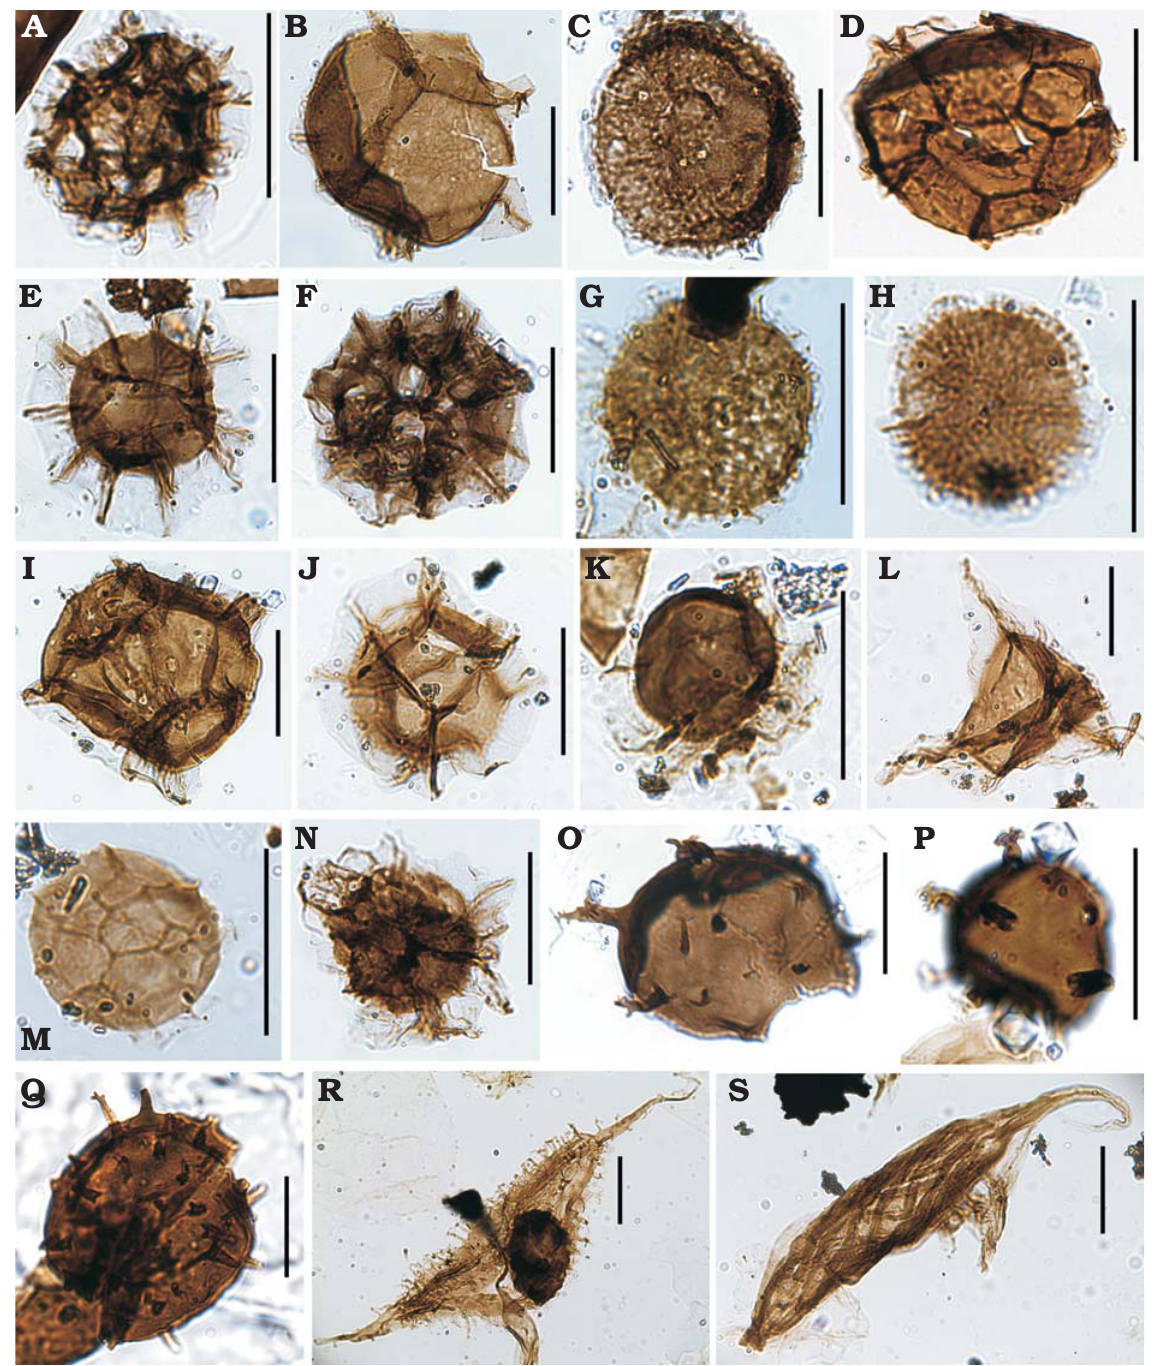
Fig. 6. Palynomorphs from the studied sections of the Los Espejos Formation of Argentina, Quebrada Ancha, P ř ídolí (A, B, D, H, N), Quebrada Ancha, Ludfordian (C, E, F, I, J, L, O–Q), Cerro La Chilca, Ludfordian (G, K, M, R, S). A . Cymatiosphaera cf. densisepta Le Hérissé, 2000; MPLP 10- 60673 (J43/1). B . Cymatiosphaera heloderma Cramer and Díez, 1972; MPLP 9-60664 (X27/2). C . Cymatio sphaera jardinei Cramer and Díez, 1976; MPLP 8-60677 (U51/3). D . Cymatiosphaera lawsonii Mullins, 2001; MPLP 9-60664 (O28/3). E . Cymatiosphaera aff. ledburica Mullins, 2001; MPLP 7-60736 (L41/2). F . Cymatiosphaera cf. mirabilis Deunff, 1959; MPLP 8-60677 (U50/1). G . Cymatiosphaera multicristata Mullins, 2001; MPLP 4-61059 (G28/2). H . Cymatiosphaera aff. multisepta Deunff, 1955, Mullins, 2001; MPLP 10-60673 (K46/3). I . Cymatiosphaera nimia Le Hérissé, 2002; MPLP 8-60677 (T50/1). J . Cymatiosphaera octoplana (Downie, 1959) Mullins, 2001; MPLP 7-60736 (Q32/2). K . Cymatiosphaera